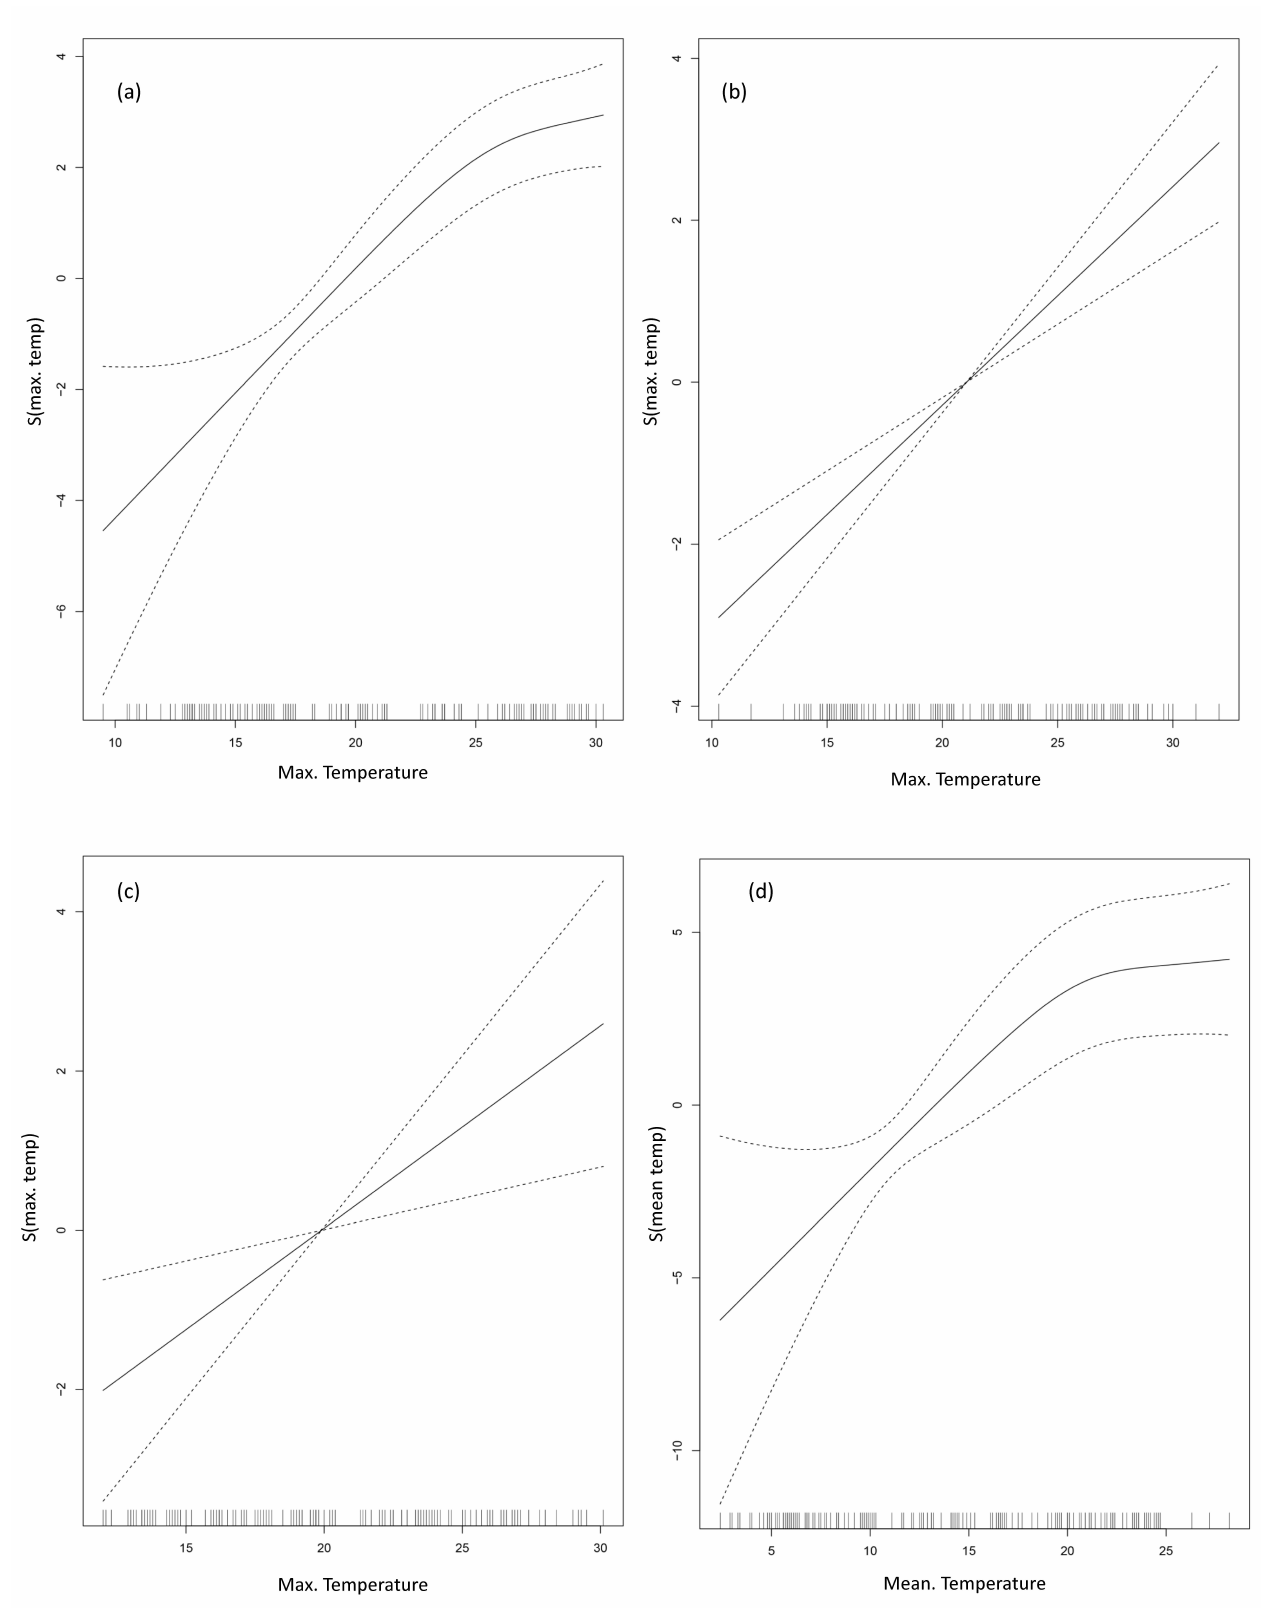
Figure 4. Association between seawater temperature and the incidence of V. vulnificus cases on each coast (general additive model analysis). The central solid line represents central estimates, and the dashed line represents 95% confidence